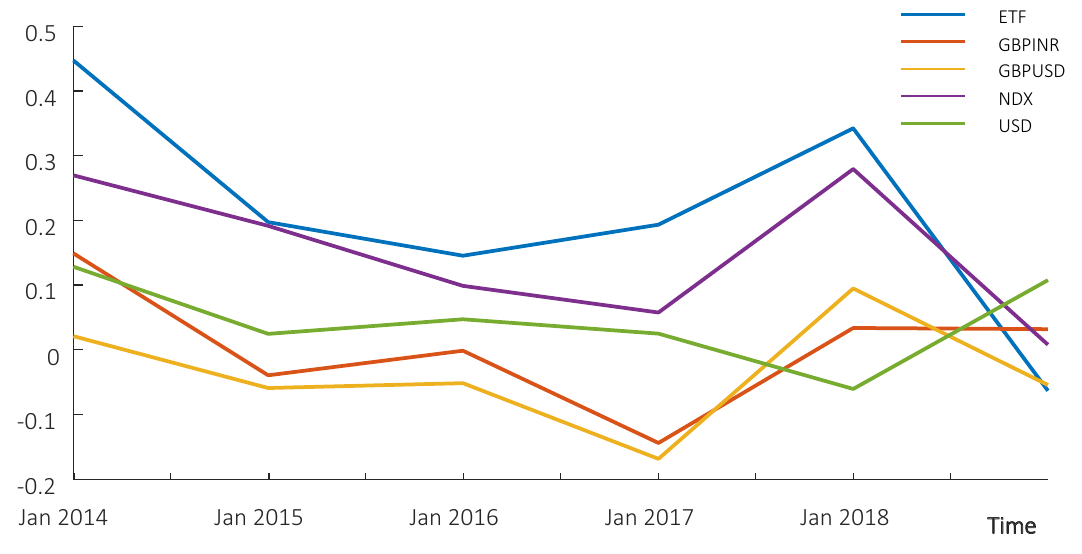
Figure 6. Time series plot of ETF, GBPINR, GBPUSD, NDX, USD